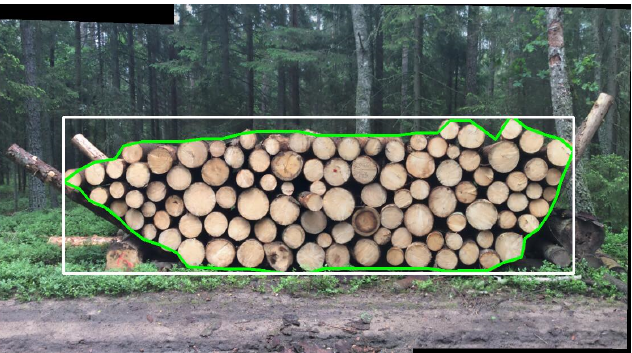
Figure 1. Identification of a stacked wood polygon by the iFovea application. (Fot. W. Sarzyński). During timber measurement, the position (location) is automatically recognized and recorded by GPS. This makes it possible to visualize the map with the measured pile data on a smartphone.